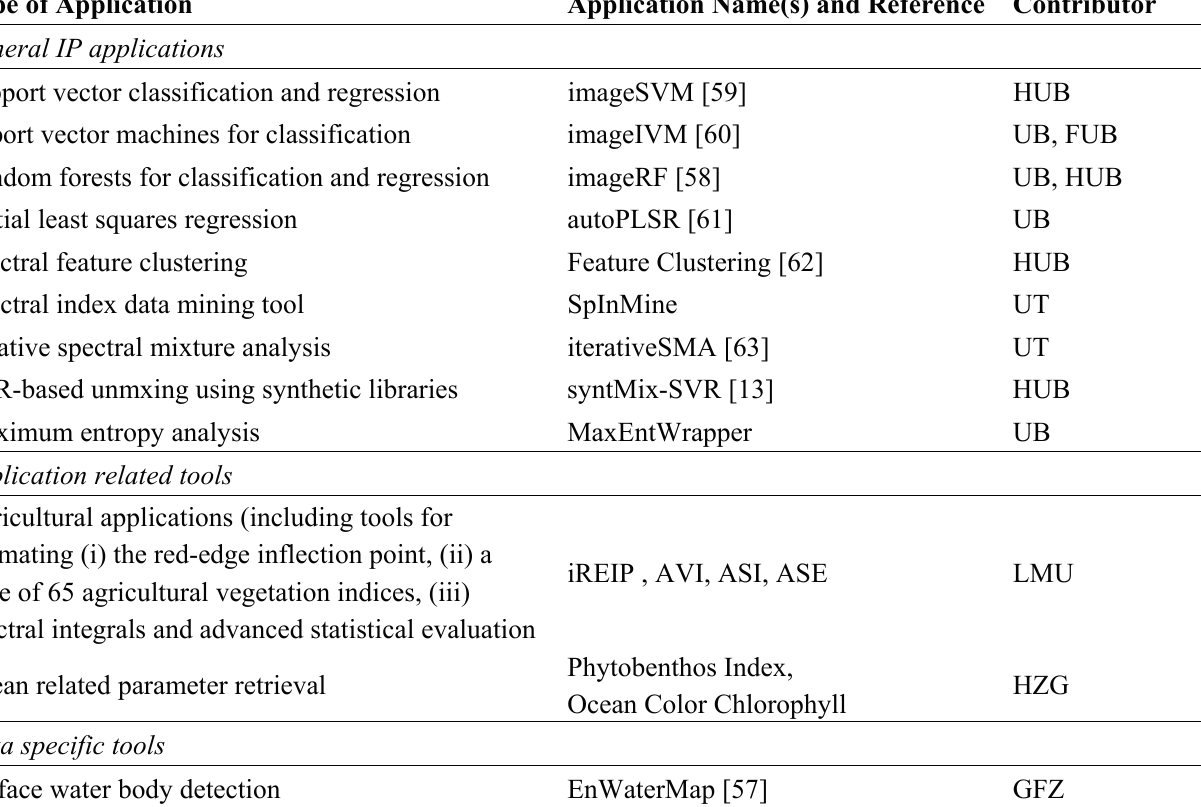
Table 1. List of available applications in EnMAP-Box version